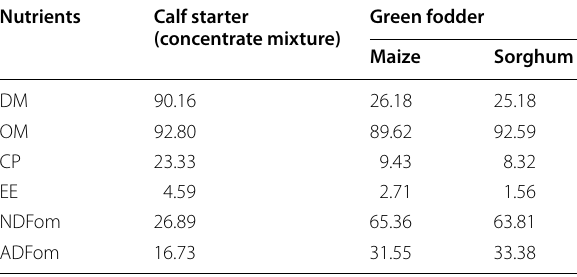
Premix provided per kilogram of concentrate: vitamin A, 15,000 IU; vitamin D, 5000 IU; vitamin E, 50 mg; Fe, 90 mg; Cu, 12.5 mg; Mn, 30 mg; Zn, 90 mg; Se, 0.3 mg; I, 1.0 mg